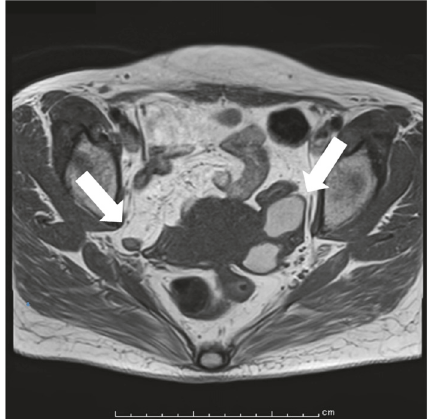
Figure 2: Posttreatment magnetic resonance imaging of our patient with endometriosis. Axial T1-weighted imaging after seven years of treatment. The two tumors show high-intensity signals with a diameter of 35 mm or less (arrow), and the tumor size was a partial response.